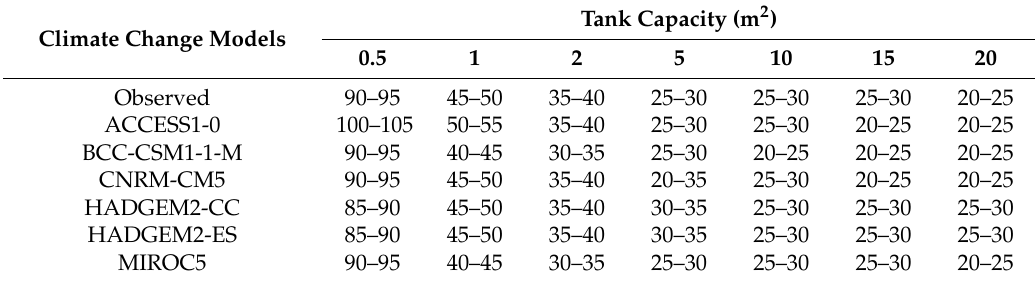
Table 5. SON roof size required for 80% reliability for varying tank sizes (2025–2055).